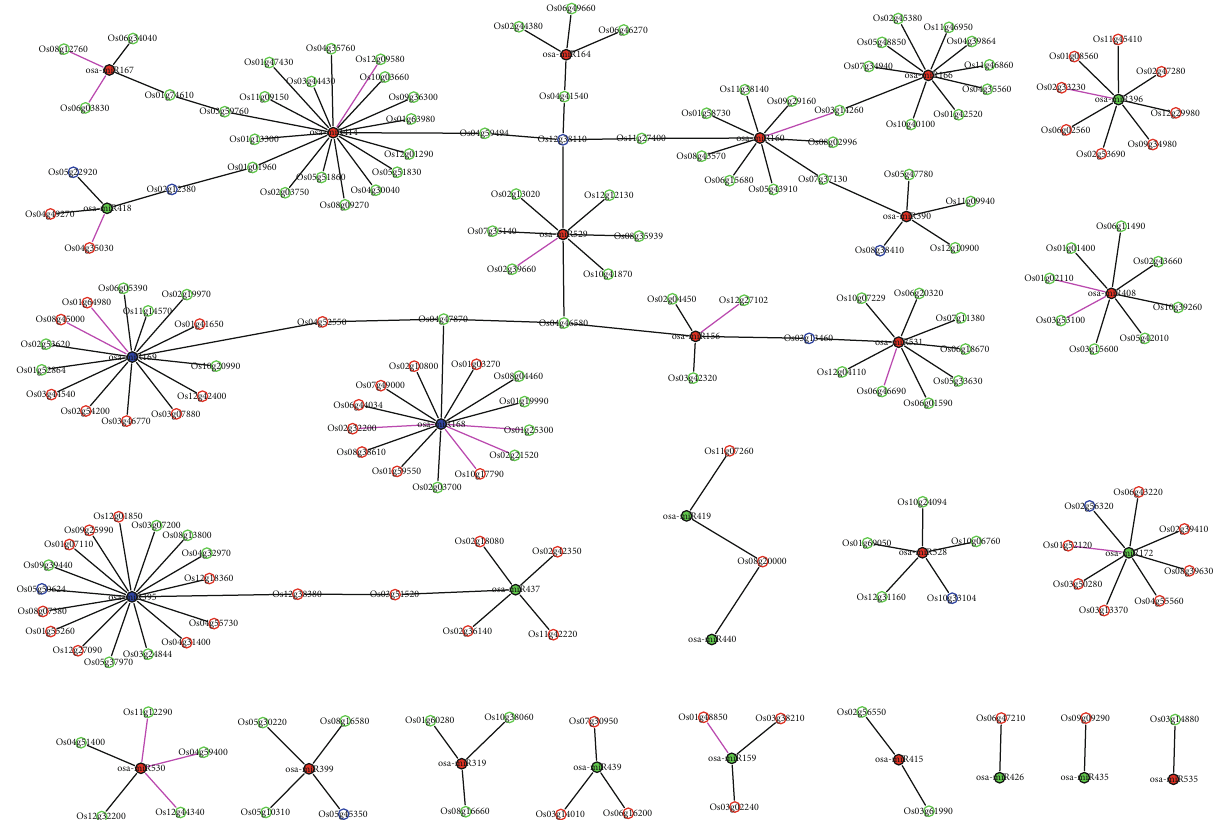
Figure 5: Network visualization of miRNA-PPI in rice post-meiosis panicles. The node colors of red, green, and blue denote three expression patterns: upregulated, downregulated, and up-/downregulated pattern, respectively. The black edges represent cleavage, and the red edges represent translation inhibition in the miRNA-target module. The edge color of PPI denotes the combined score. The larger the combined score is, the darker the color is. The “ LOC ” of the pre fi x for the gene name in the network was omitted for